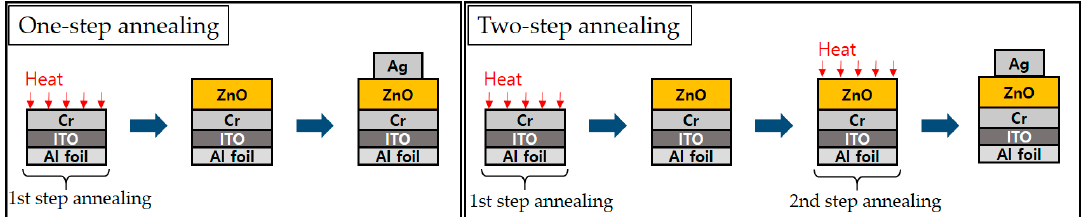
Figure 3. Schematics of the one-step and two-step annealing processes defined in this work.